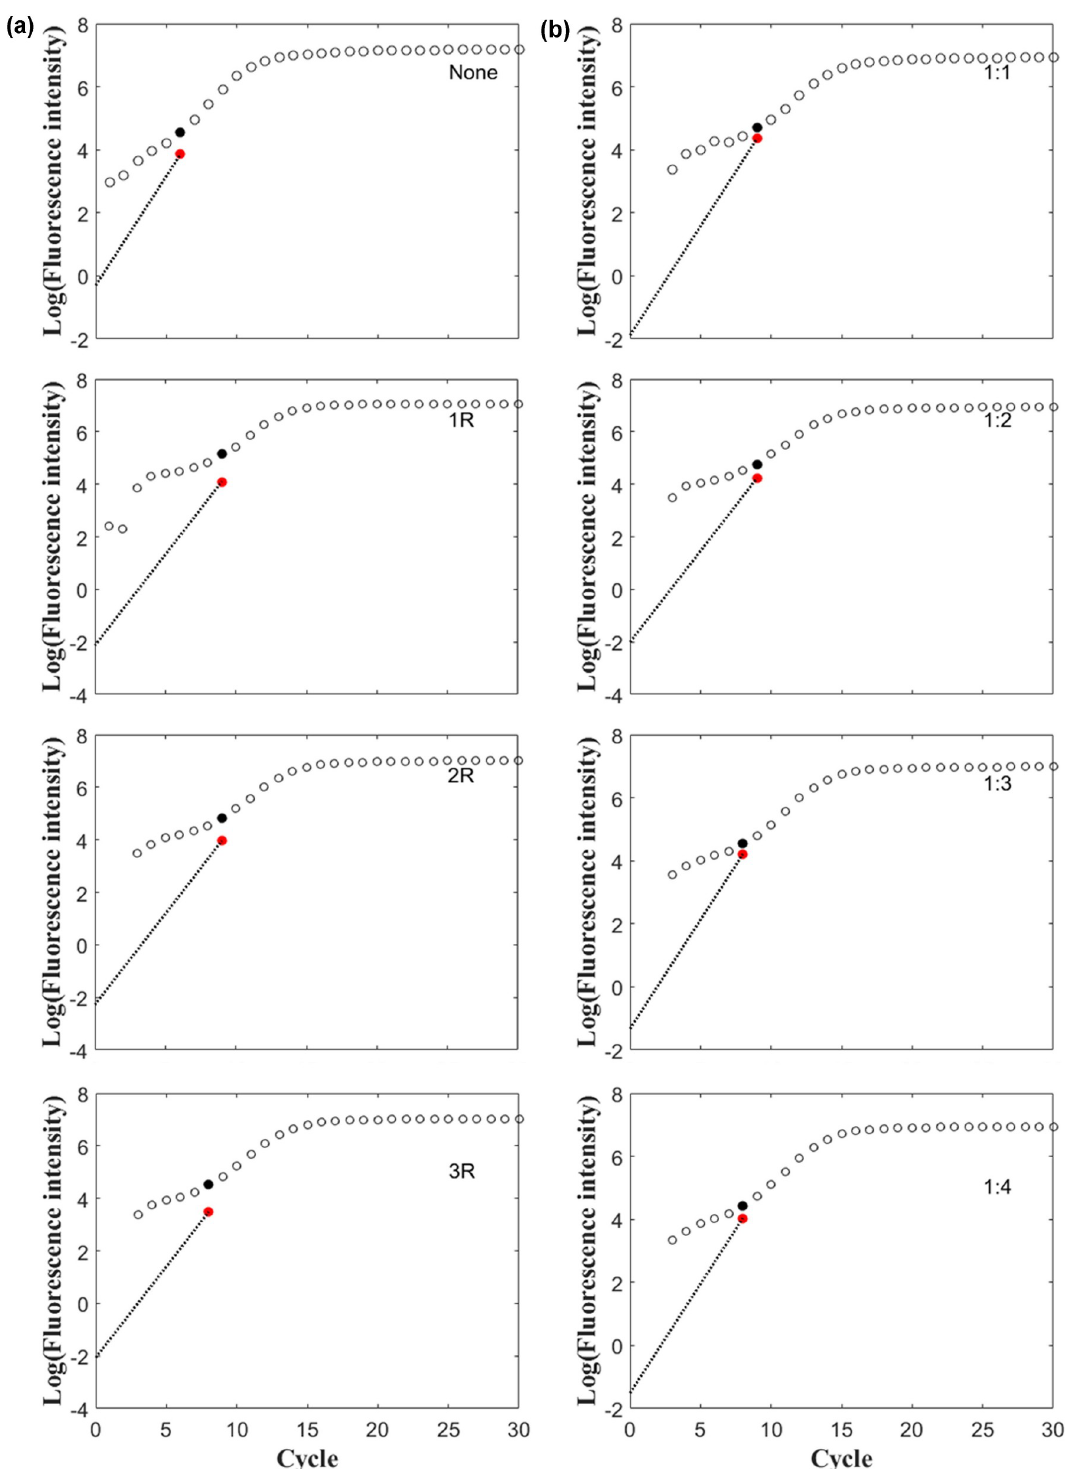
Fig 6. Effects of different combinations of matched and mismatched primers on outlier emergence. (a), PCR amplification with changed position of the outlier cycle using a pair of primers both with two mismatched nucleotides located at the 9 th and 10 th (middle position), 12 th, and 13 th , 13 th and 14 th nucleitides represented by 1R, 2R, and 3R, respectively. (b), Ratios of mismatched primers to the non-mismatched primers represented by 1:1, 1:2, 1:3, and 1:4, respectively.